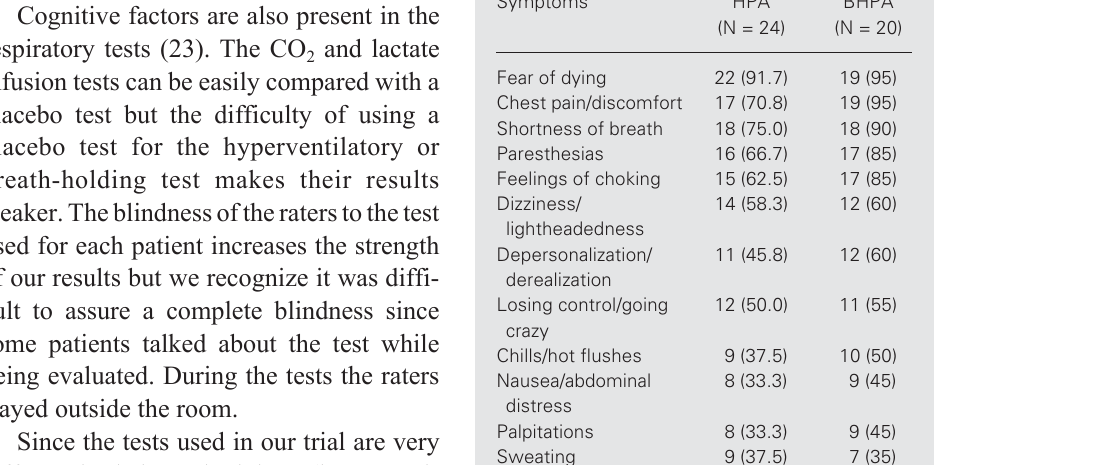
Table 3. Frequency of panic attack symptoms in the hyperventilation-sensitive panic attack group (HPA) vs the breath-holding-sensitive panic attack group (BHPA).